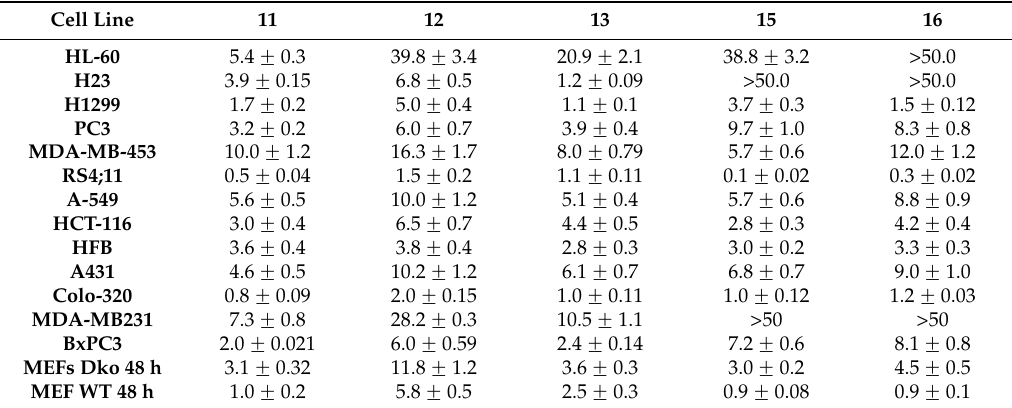
Table 4. Cytotoxicity of selected Aurora A inhibitors, µ